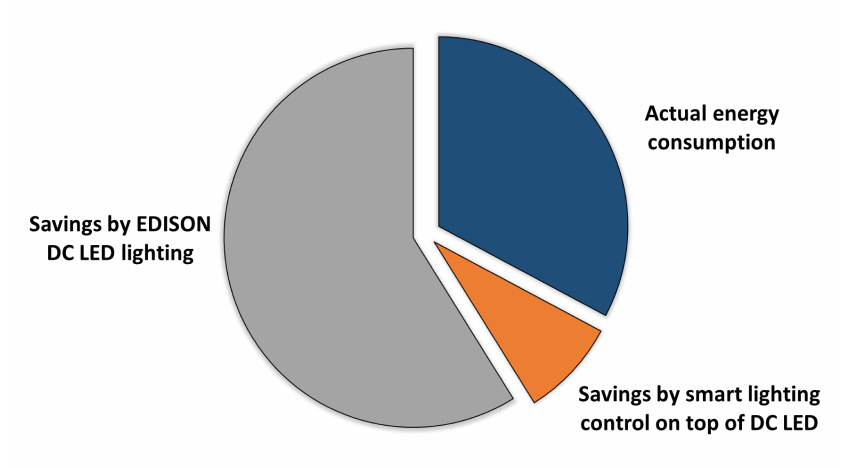
Figure 14. Pie chart representing actual energy consumption of the EDISON system, savings by migrating to DC-based LED lighting and savings by smart lighting